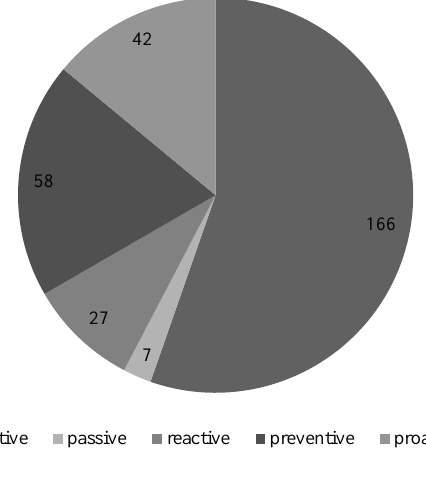
Figure 2. Social media used for eco-innovation processes within